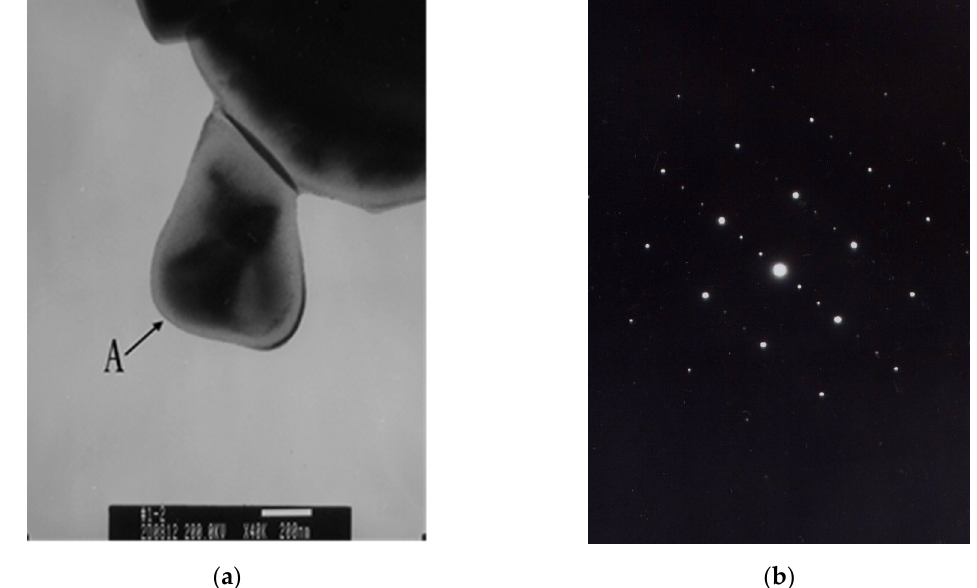
Figure 2. Transmission electron microscope (TEM) bright field image ( a ) and its corresponding selected area diffraction (SAD) pattern ( b ) of Phase A.